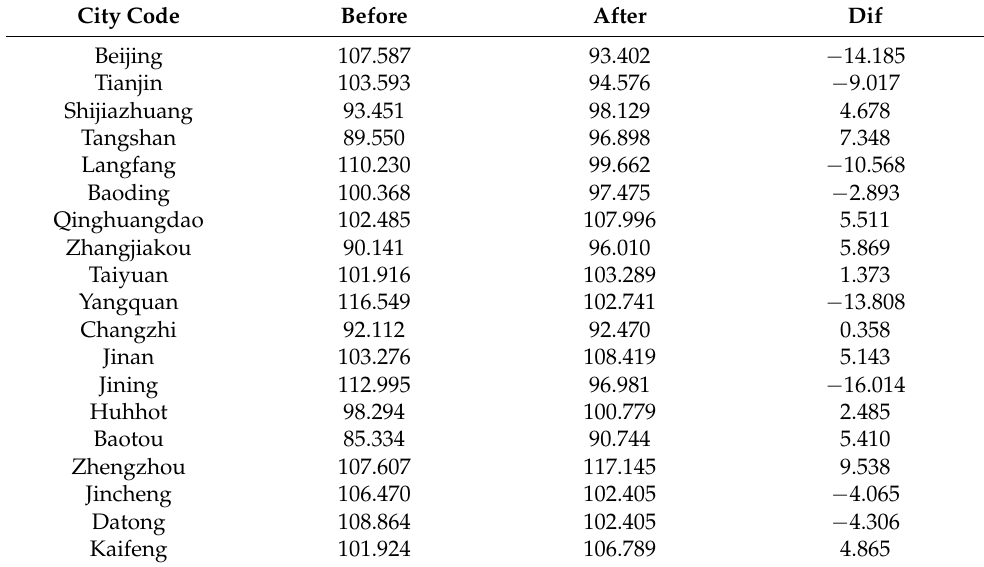
Table 2. The change values of different cities before and after the policies.